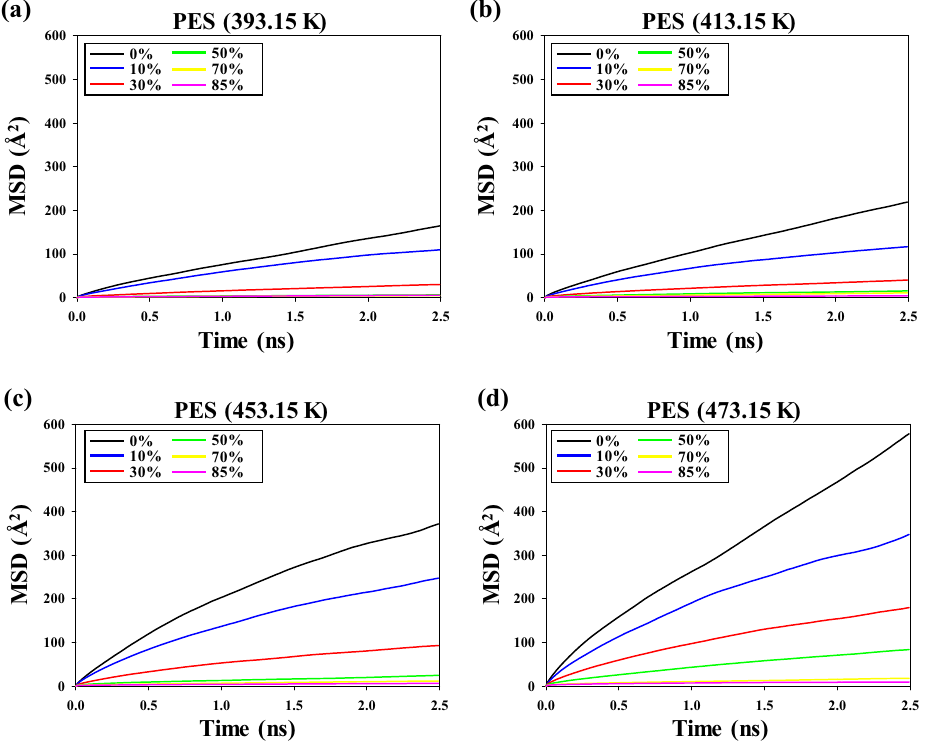
Figure 3. Mean squared displacement (MSD) of PES at ( a ) 393.15 K, ( b ) 413.15 K, ( c ) 453.15 K, and ( d ) 473.15 K.